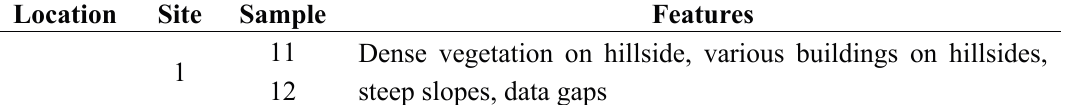
Table 1. Features contained in the dataset provided by the ISPRS for algorithm testing. Location